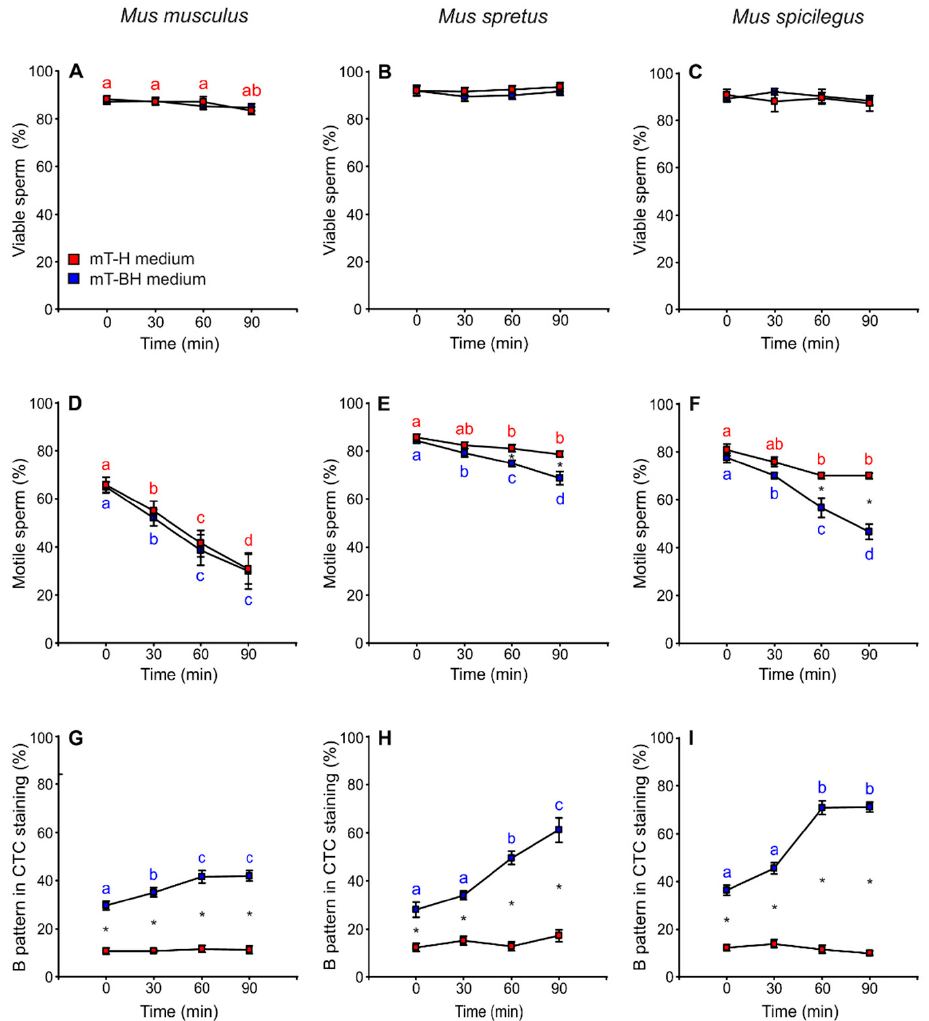
Figure 2. Variation in sperm viability, sperm motility, and capacitated sperm in M. musculus , M. spretus and M. spicilegus incubated under non-capacitating conditions (mT-H medium) and capacitating conditions (mT-BH medium). Data are means ± SE ( n = 7 in M. musculus , n = 8 in M. spretus